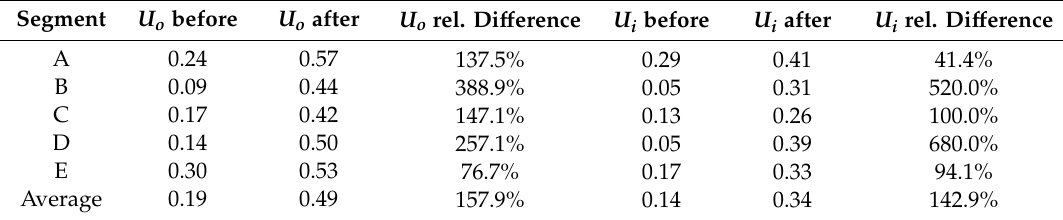
Table 1. The overall and longitudinal uniformities in the road segments (A–E) on the road surface before and after the vegetation trimming. Furthermore, the relative (rel.) differences between the 2015 and 2019 measurements for the both uniformity measures are presented in their individual columns.